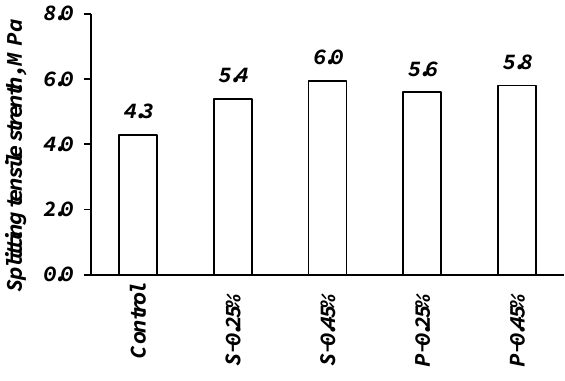
Figure 7. Effect of fibers on the splitting tensile strength.